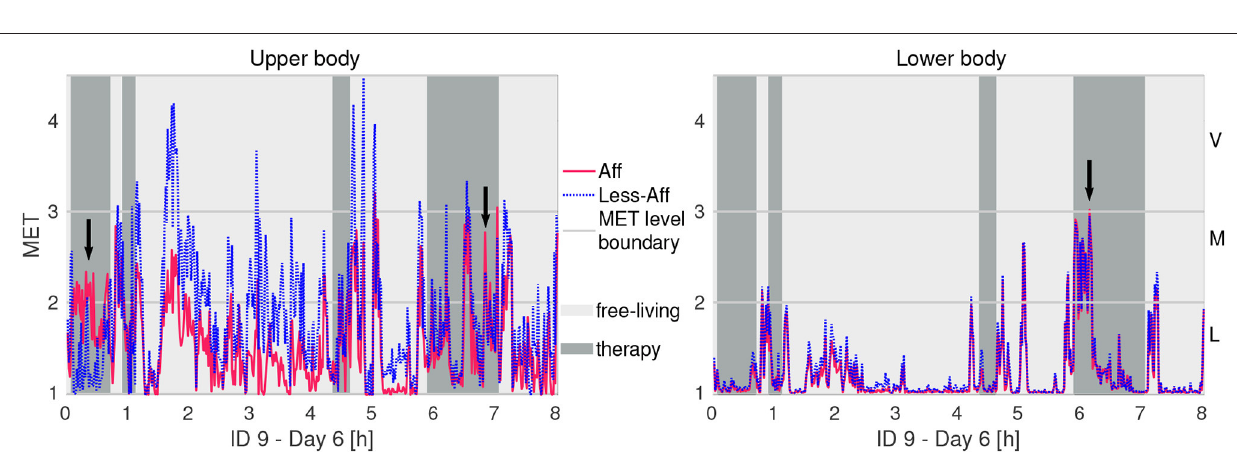
FIGURE 4 | Example of physical activity in MET equivalents of recording day 6 of patient ID9 (walker). Letters L , M , and V denote thresholds for light, moderate, and vigorous activity intensity, respectively. Arrows indicate higher activity intensity in the affected side compared to the less-affected